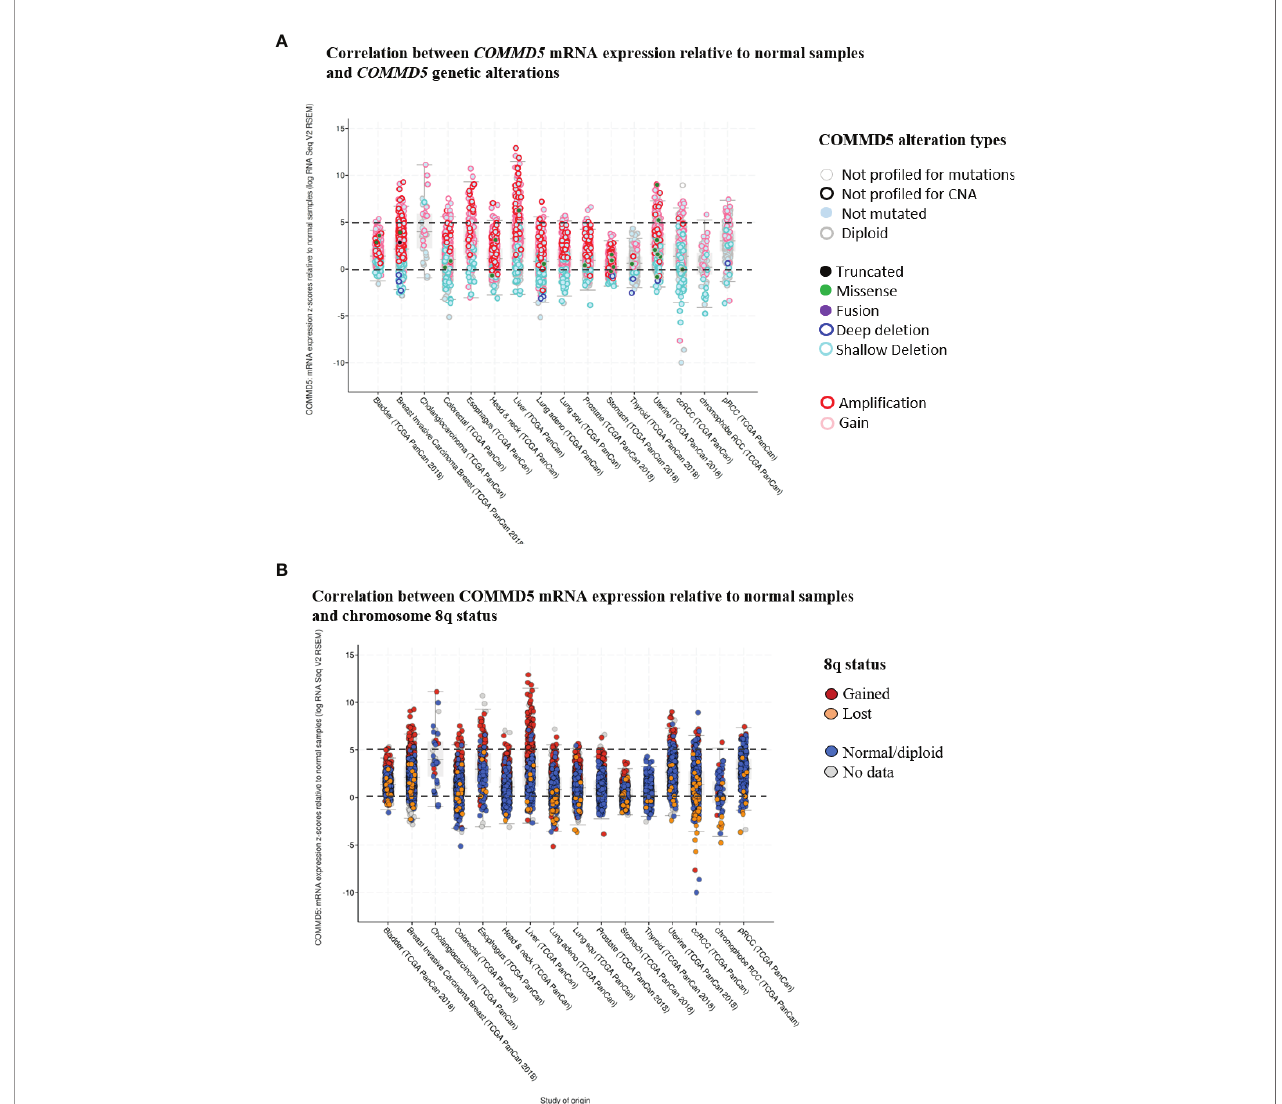
FIGURE 4 | Correlation between COMMD5 mRNA expression relative to normal samples and COMMD5 genetic alterations or chromosome 8q status in several cancer types. cBioportal database (42, 43) was used to analyze COMMD5 mRNA expression relative to normal samples in several cancer types using data generated by the Cancer Genome Atlas (TCGA). This analysis included data from 10,967 samples of different human tumor types used in 32 studies. (A) Plot showing correlation between COMMD5 mRNA levels relative to normal samples and COMMD5 genetic alteration in several cancer types. As indicated in the cBioportal database: Deep deletion indicates a deep loss, possibly a homozygous deletion; Shallow deletion indicates a shallow loss, possibly a heterozygous deletion; Gain indicates a low-level gain (a few additional copies, often broad); Ampli fi cation indicates a high-level ampli fi cation (more copies, often focal). (B) Plot showing correlation between COMMD5 mRNA expression relative to normal samples and chromosome 8q status in several cancer types (including 8q ampli fi cation “ gained ” , 8q deletion “ lost ” , no changes in 8q status “ normal diploid ” and no data). Abbreviations: Lung adeno, lung adenocarcinoma; Lung squ, lung squamous cell carcinoma; ccRCC, clear cell renal cell carcinoma; pRCC, papillary renal cell